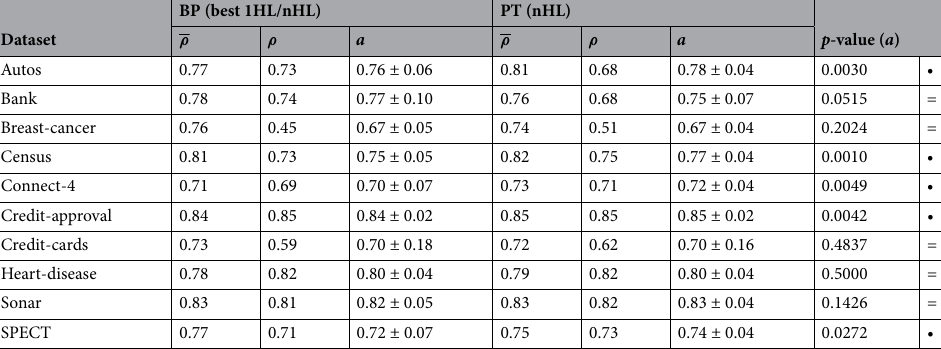
Table 1. Comparison, with focus on accuracy , between BP and PT applied to non trivial datasets (all from UCI). For each dataset, 100 training and test sets have been generated by random splitting. On the backpropagation side, experiments have been performed on two kinds of MLPs: one equipped with one hidden layer and the other with a shape identical to the one selected for PT. The best results obtained on the backpropagation side has been retained for each dataset. Results in favour of/against PT are highlighted with black/white circles, whereas results with no significant difference are highlighted with an equal sign. Two-sample Welch’s t -test has been used to check the similarity between the outcomes of different kinds of classifiers. The significance level for p -values has been set to 0.05. Also standard deviation is reported for accuracy. Legenda: 1HL / nHL = MLP with one/more than one hidden layer, ρ = specificity, ρ = sensitivity, and a = accuracy.